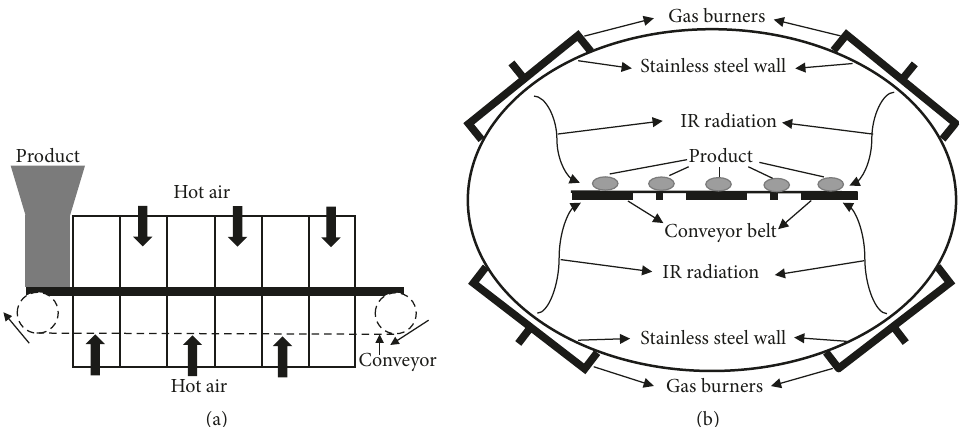
Figure 1: Schematic illustration of (a) hot air impingement oven (adapted from Adelsberg and Sanders, 1997) and (b) infrared heating in a radiant wall oven (adapted from Kettler et al.,